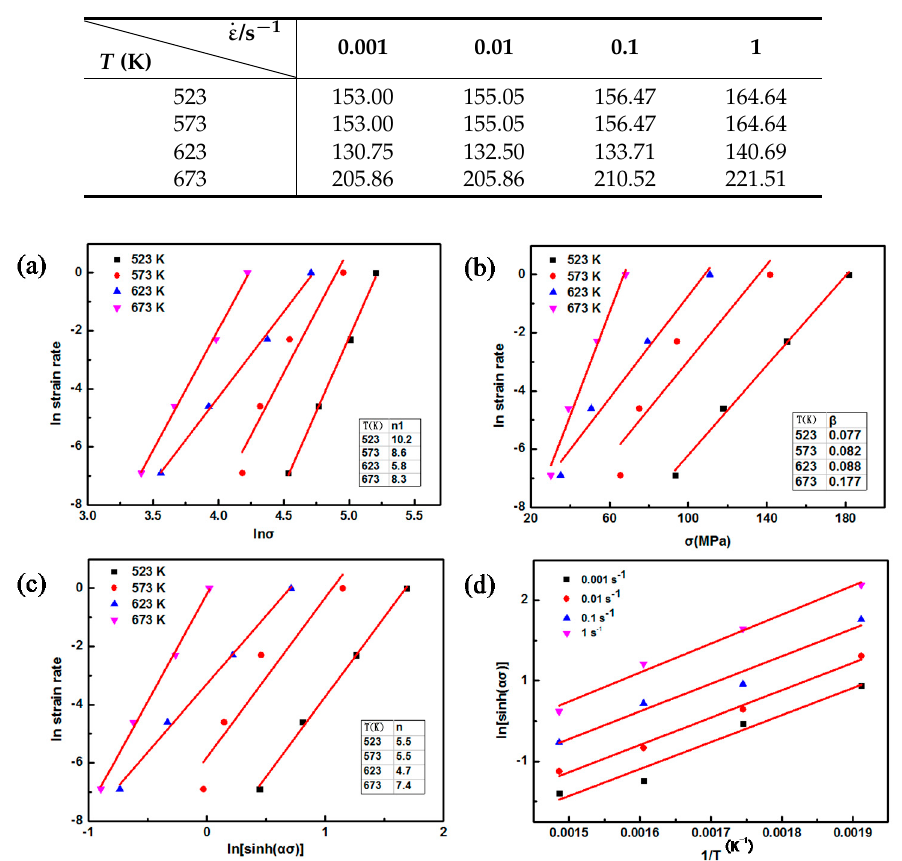
Table 3. Activation energy (kJ/mol) for AZ91 alloy after hot deformation.